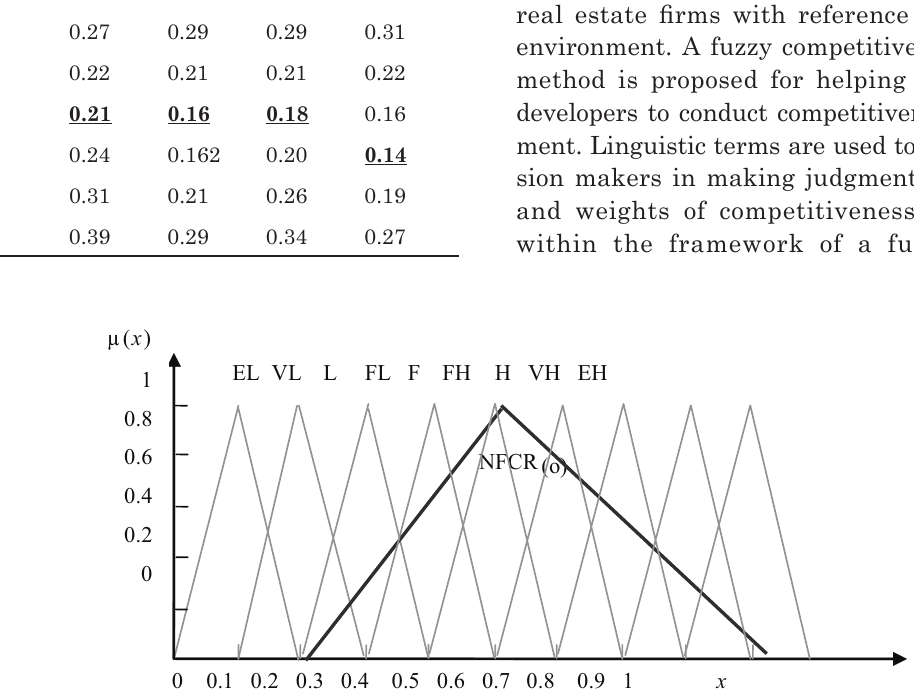
to the natural language expression (o)